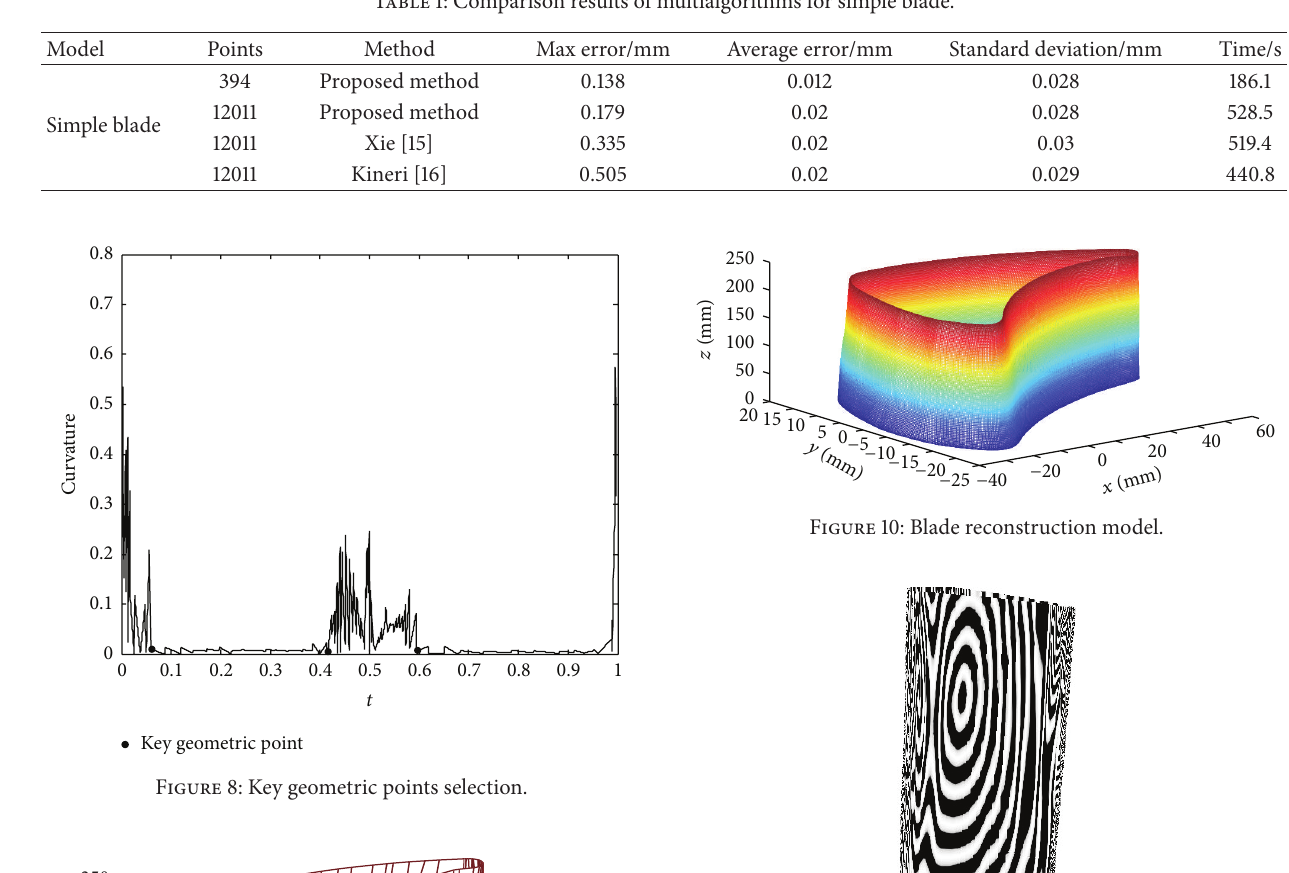
Figure 8: Key geometric points selection.